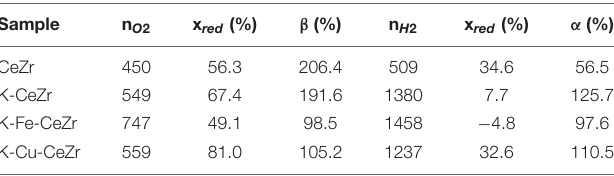
TABLE 2 | Amount (in µ mol/g) of released oxygen (as O 2 ) and produced H 2 during H 2 O splitting tests, reduction degrees after each step (x red ), oxidation yields ( α ), and reduction yields ( β ). Sample